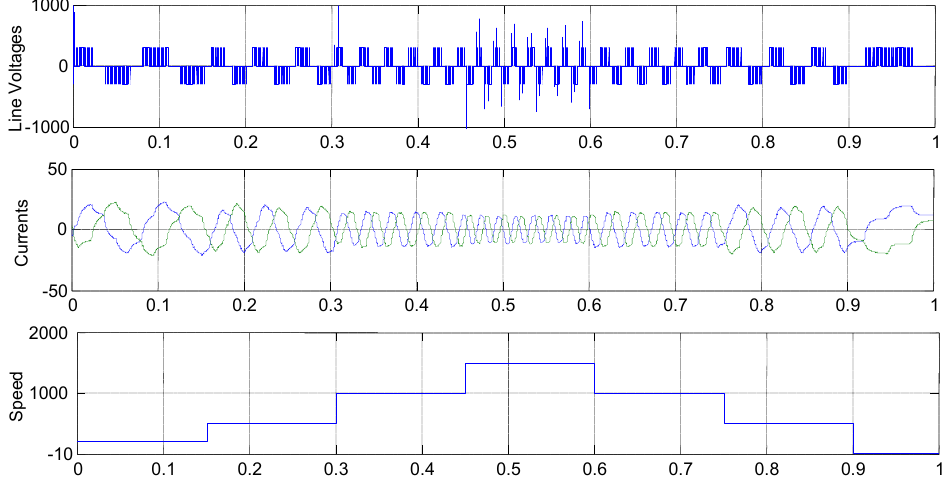
Figure 9. Effect of speed variation (increment/decrement) on voltage and current using the supple- mentary battery. Table 1. Simulation specification.